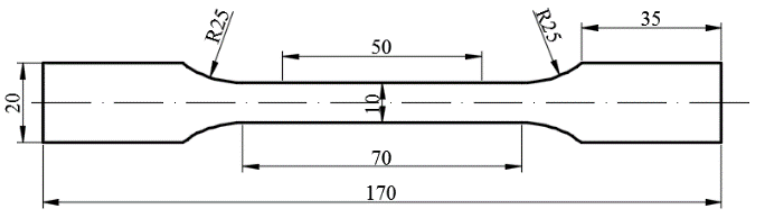
Figure 7. ZK60 magnesium alloy tensile sample.